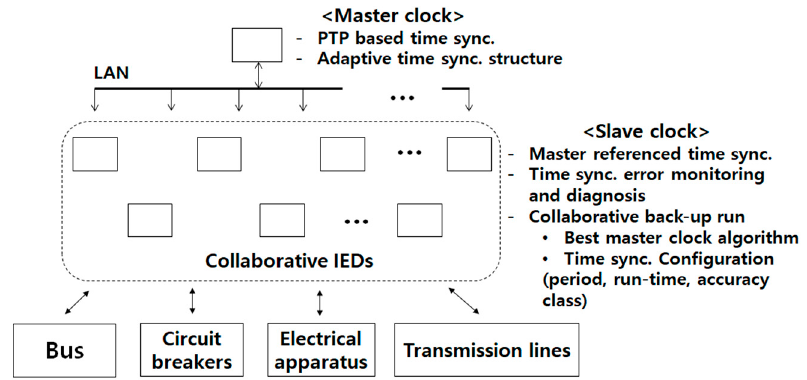
Figure 1. Time synchronizing Intelligent Electronic Device (IED)-based substation model proposed for IEC 61850-based smart substation.